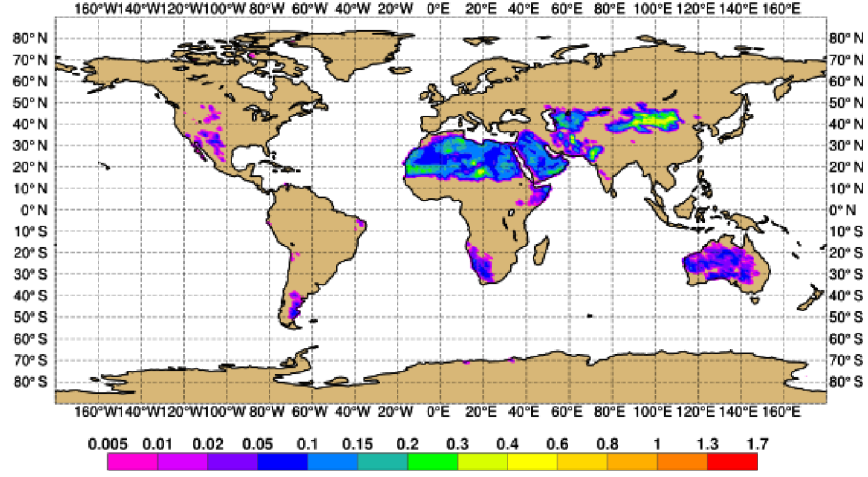
Figure 5. The 2017 total emissions of dust aerosol (kgm − 2 yr − 1